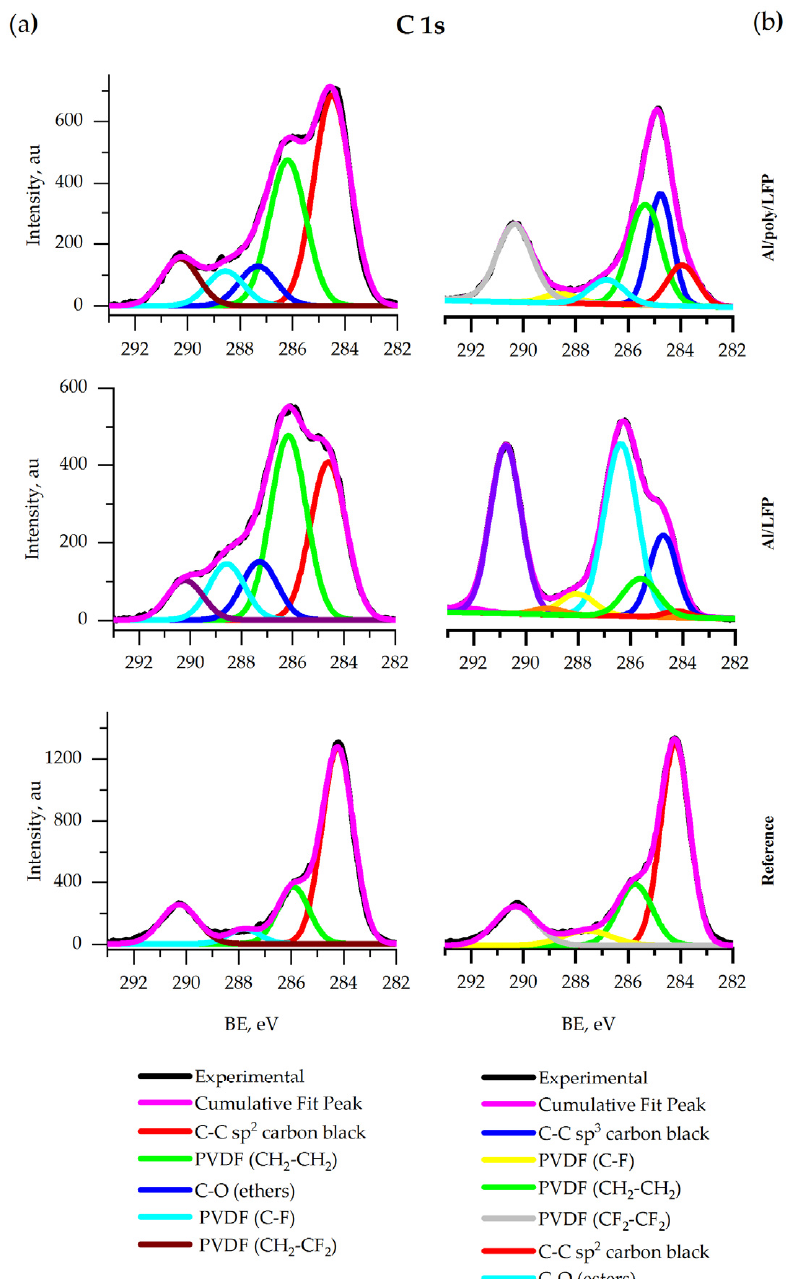
Figure 10. XPS spectra of C 1s for coin ( a ) and pouch ( b ) cells.